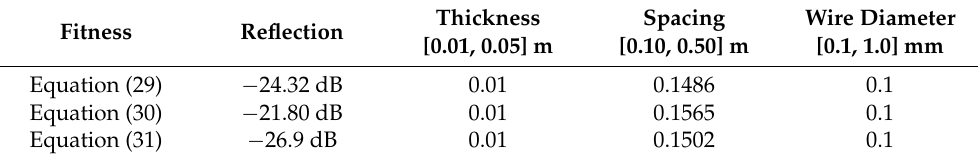
Table 1. Optimal parameters obtained through different objective functions.